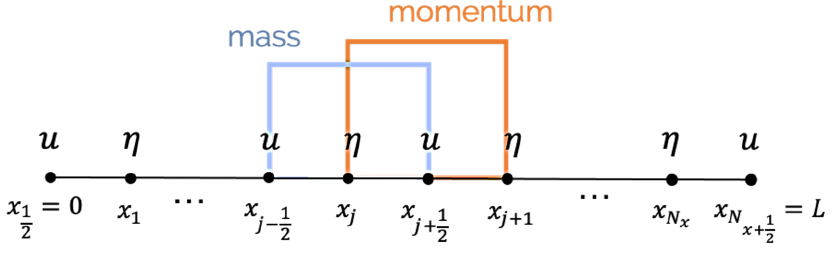
Figure 2. Meanwhile, the time interval is divided into Nt = (cid:98) T ∆ length of ∆ t .